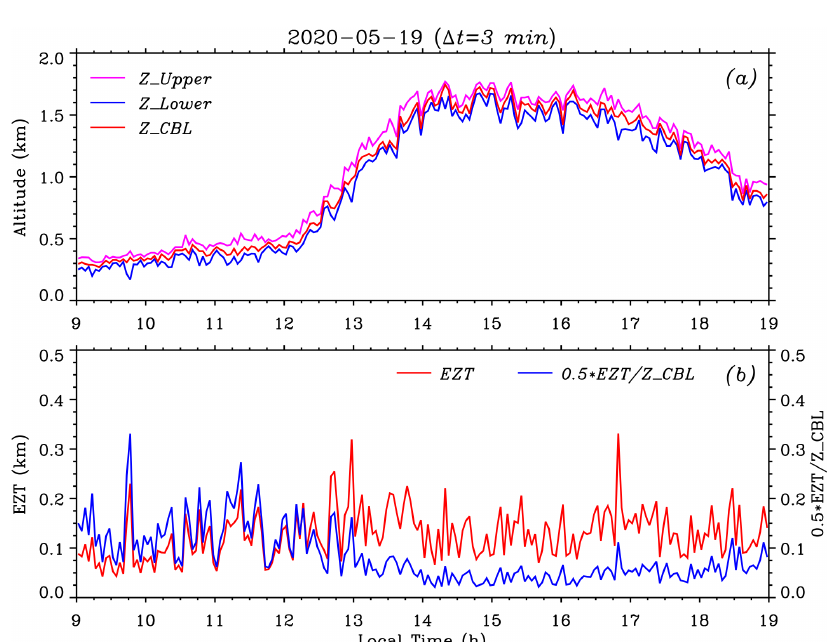
Figure 9. Same as Fig. 6 but on 19 May